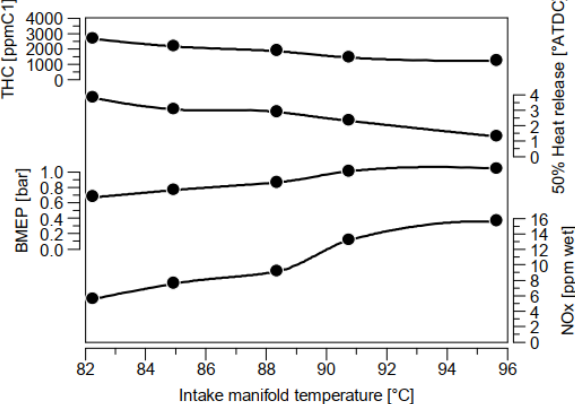
Fig. 5 Effect of an increase of intake temperature on BMEP, CA50, HC and NO X [70].